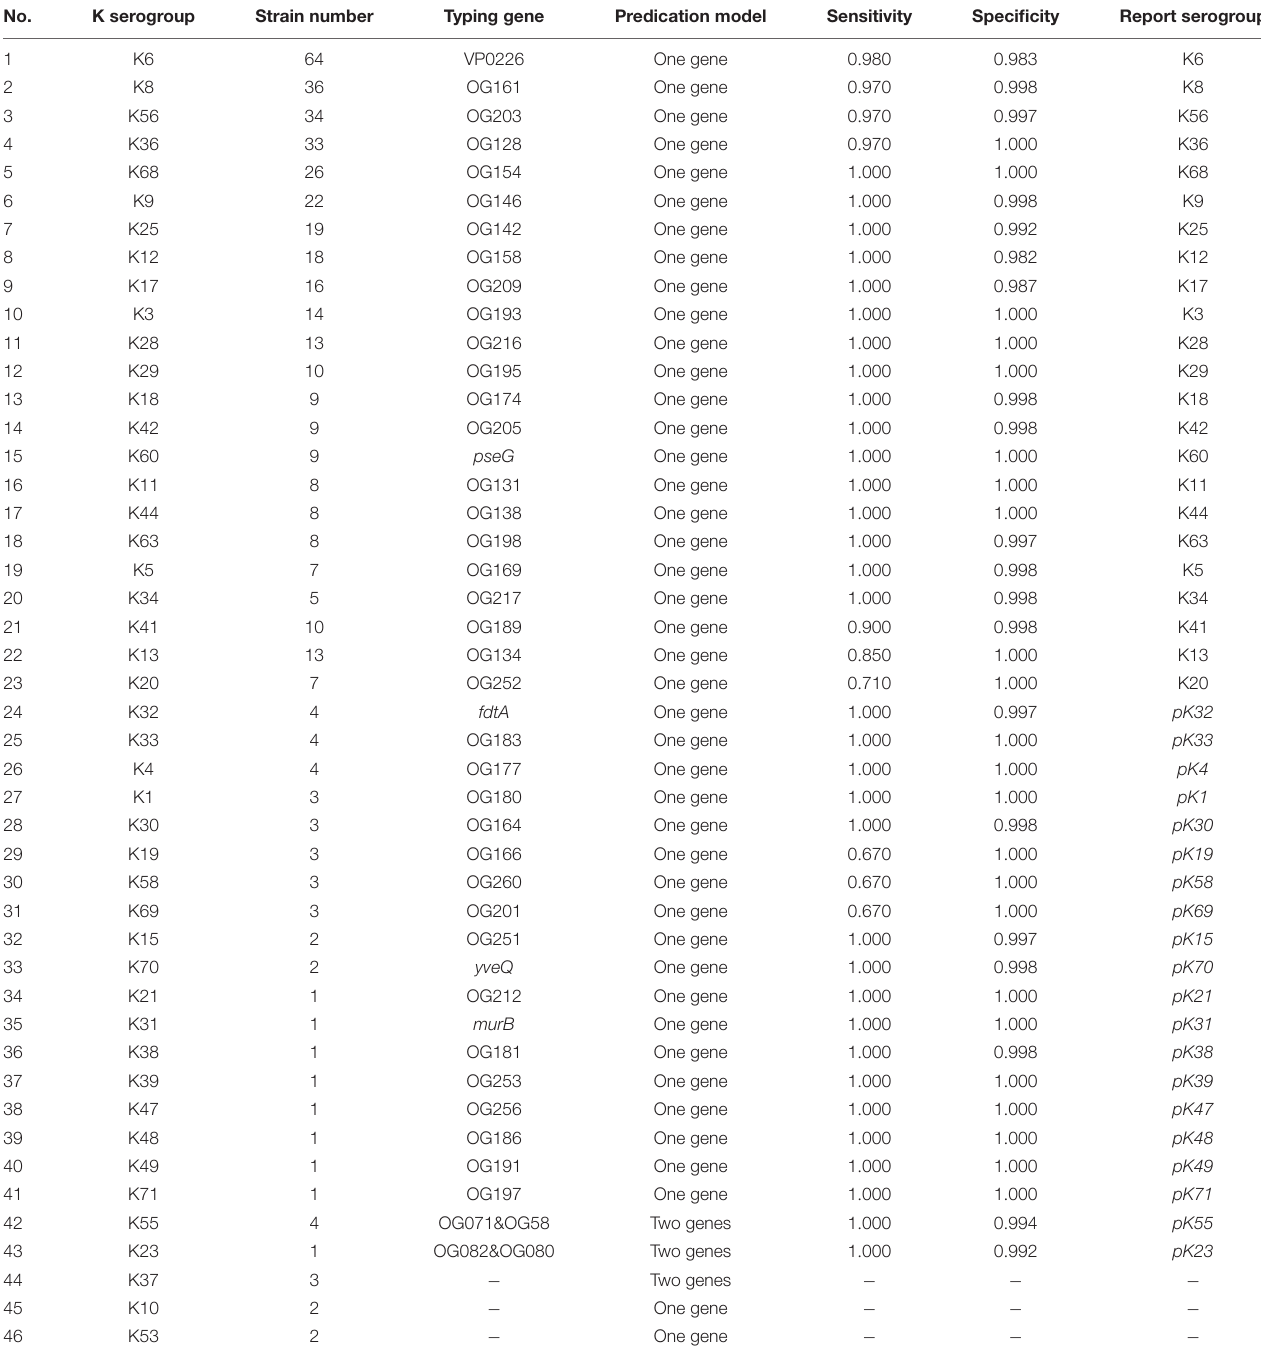
TABLE 2 | K serogroup typing genes by VPsero and corresponding sensitivity and specificity. No. K serogroup Strain